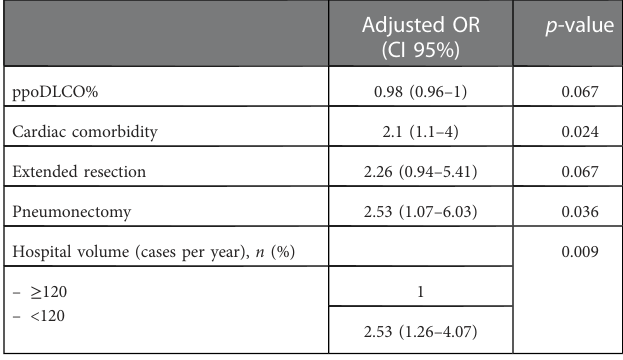
TABLE 2 Multivariate analysis of risk factors of FTR after anatomical lung resection.